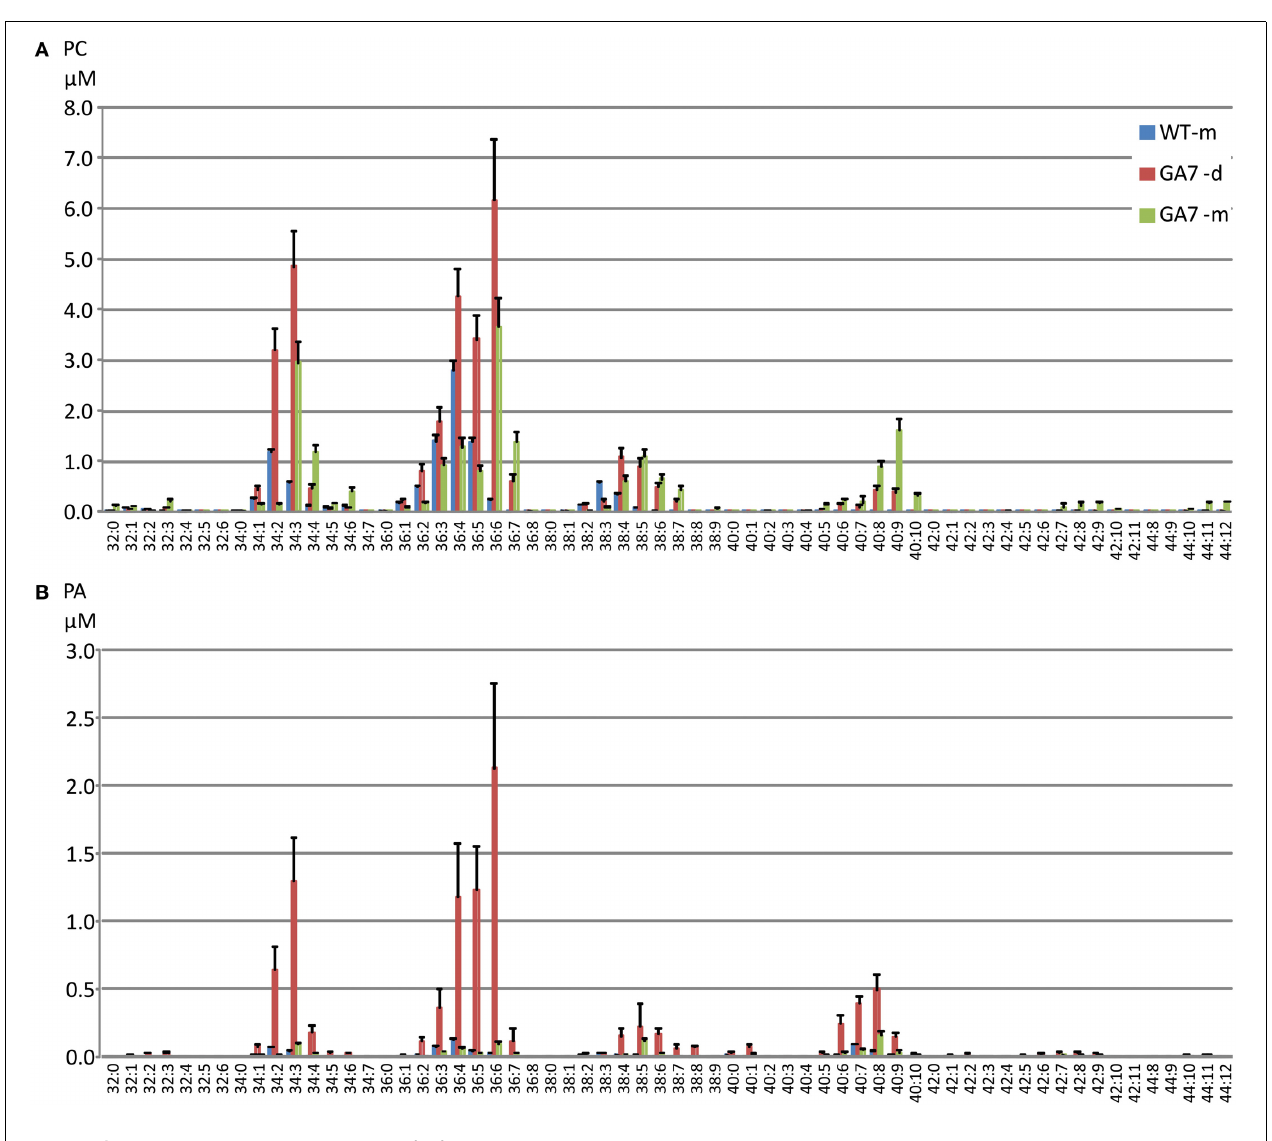
FIGURE 4 | Distribution of phosphatidylcholine (PC) and phosphatidic acid (PA) species in the developing and mature seeds from the WT or GA7 Arabidopsis seeds. The PC species (A) and PA species (B) are